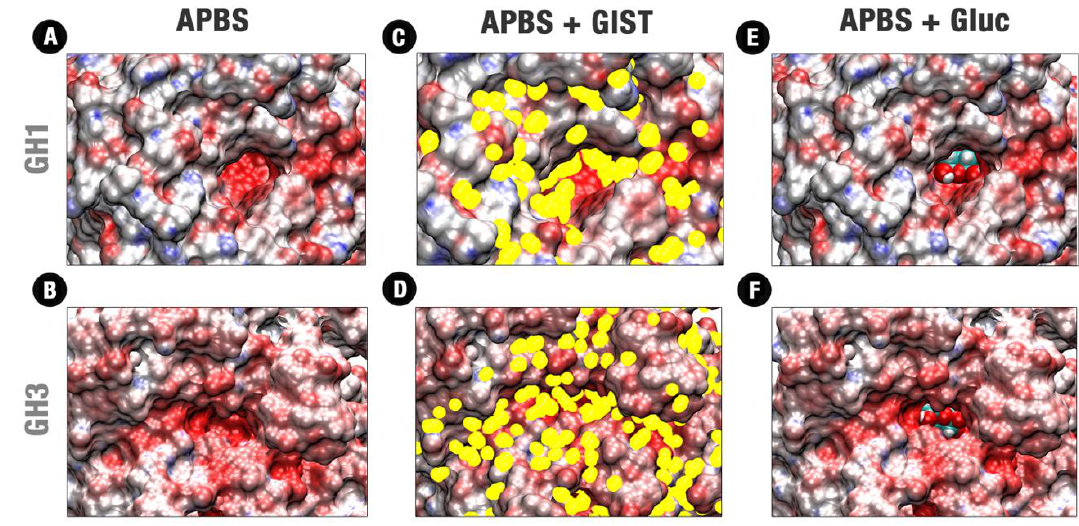
Figure 4. Confront between APBS, and GIST data and the glucose fitting in GH1 and GH3 representative poses at the catalytic cleft. ( A , B ) APBS respectively for HiBG at the pose representative of the minimum 1 in Figure 2B and AaBG at the pose representative of the minimum 2 in Figure 2C; ( C , D ) APBS and GIST results respectively for the previous pose of HiBG and AaBG ( E , F ) APBS and glucose fitting respectively for the previous pose of HiBG and AaBG. APBS scale in red, white, and blue corresponding to ψ values of − 20.00:0.00: + 20.00, respectively. GIST results are shown in yellow dots for water interacting centers with g v (O) ≥ 10.00 units of the bulk density and ∆ G v solv ≥ + 3.0 kcal / mol. Glucose is shown in cyan spheres with carbon atoms in cyan, oxygens in red, and hydrogens in white.